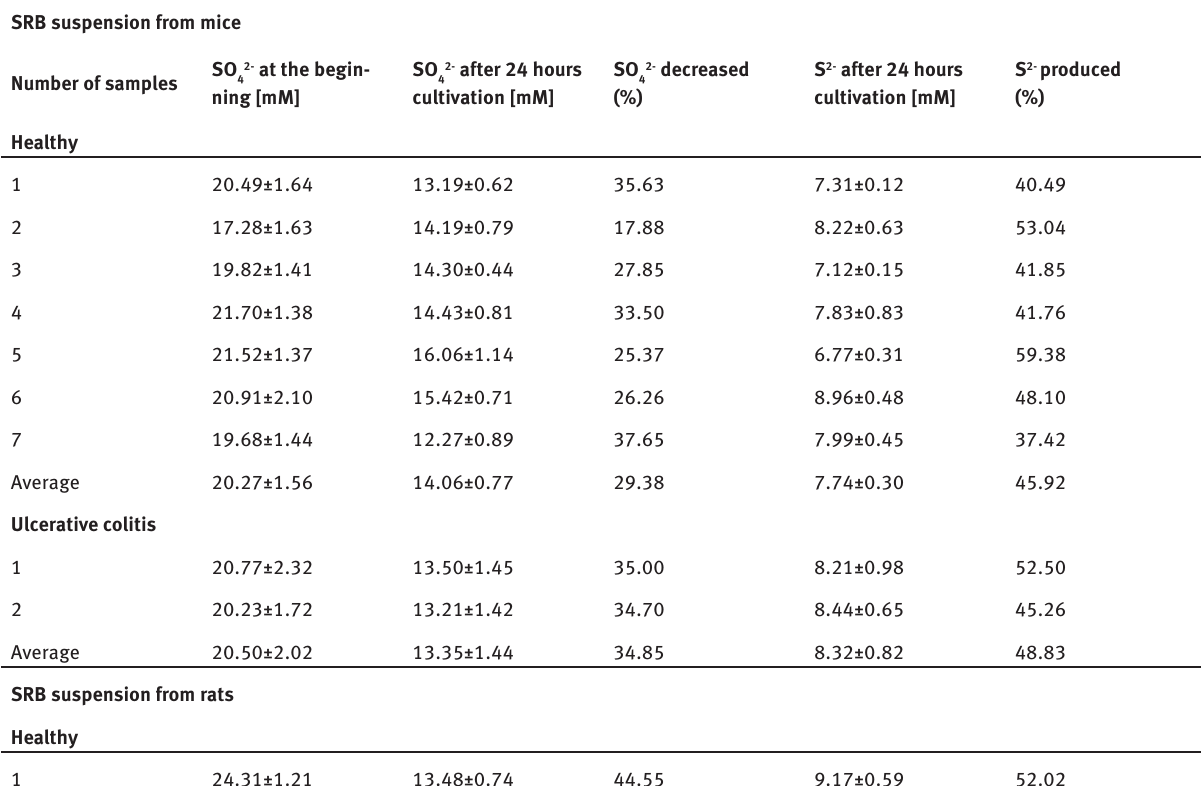
Table 1: Concentrations of sulfate and sulfide in media with intestinal SRB from mice and rats for 24 hours cycle.